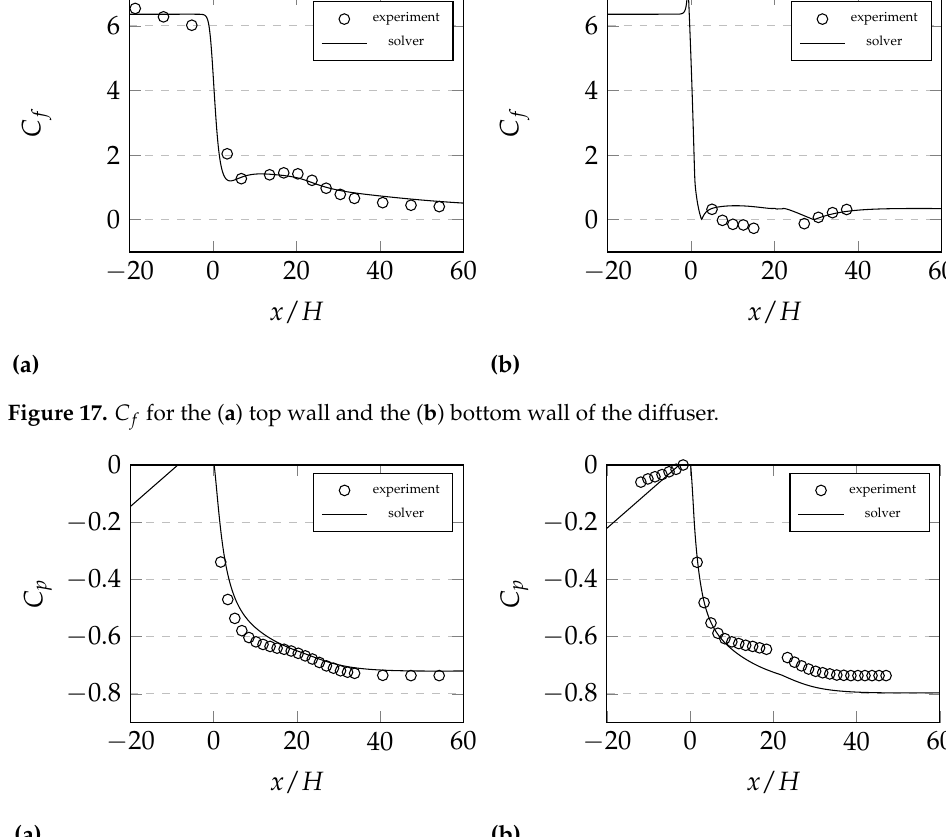
Figure 16. Current solution as compared to experimental results for y / H versus 10 at multiple x -positions along the diffuser. The origin of x coordinates is fixed at the start of the